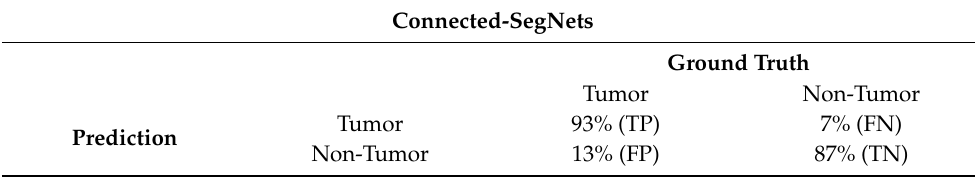
Table 5. Confusion matrix results of the proposed Connected-SegNets on CBIS-DDSM dataset.